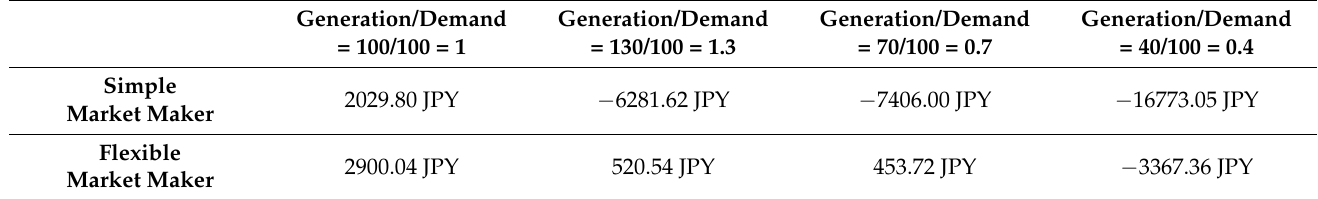
Table 13. Profit/loss of market makers with respect to different supply–demand